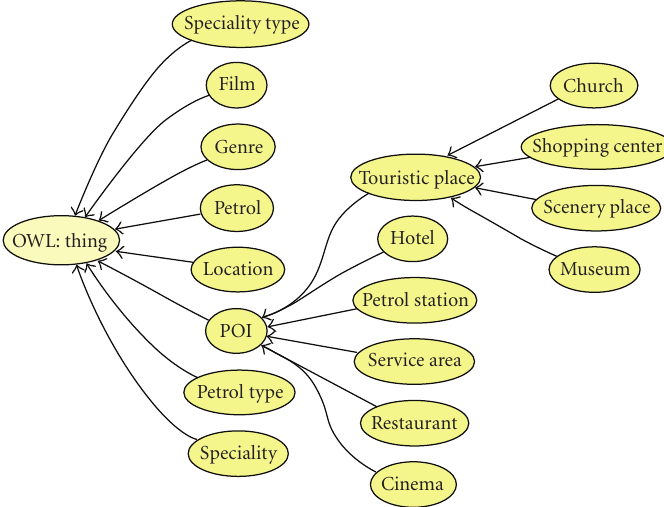
Figure 2: Hierarchical representation of Environment ontology